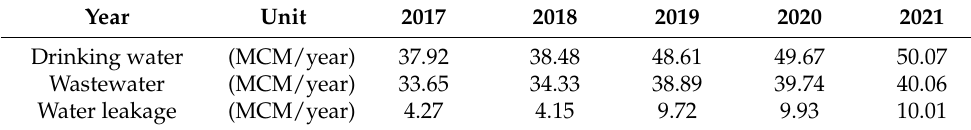
Table 2. Quantities of drinking water, sewage water and leakage water for different